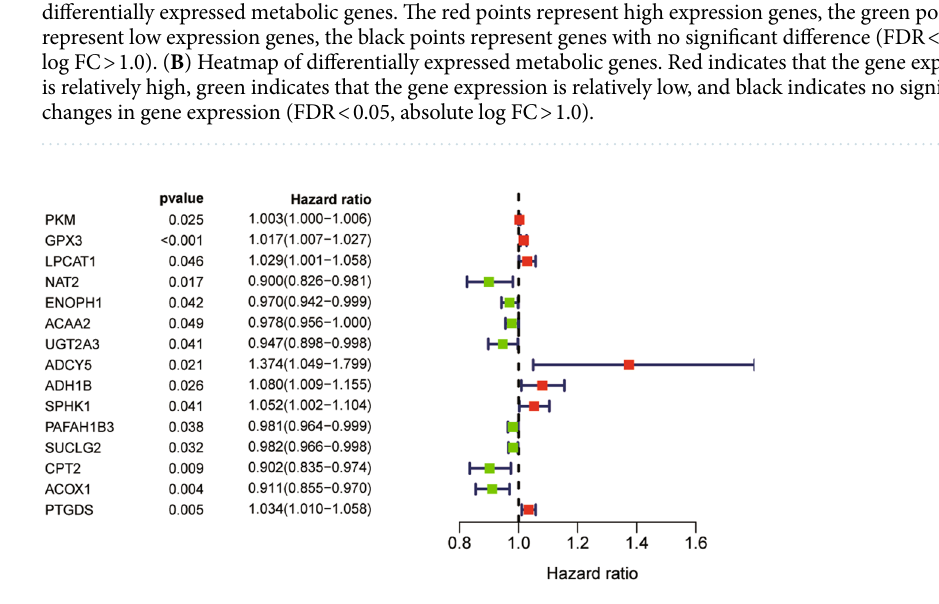
Figure 2. Forest plot of the univariate Cox regression analysis showing the prognostic metabolic genes. Genes with HR < 1 have better overall survival outcomes, while genes with HR > 1 have worse overall survival